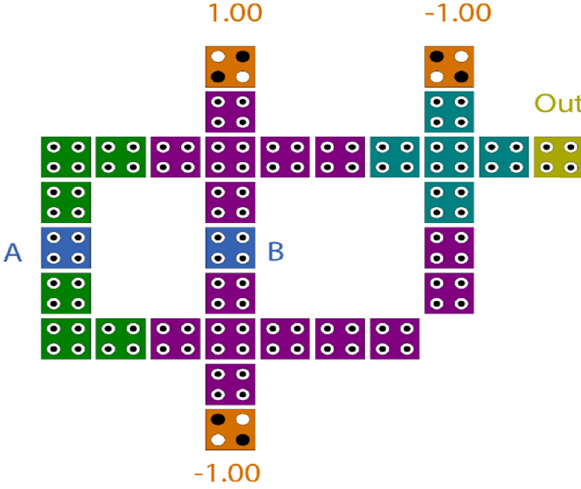
Figure 6: 2 - input XOR gate proposed in ref. [ 29 ]